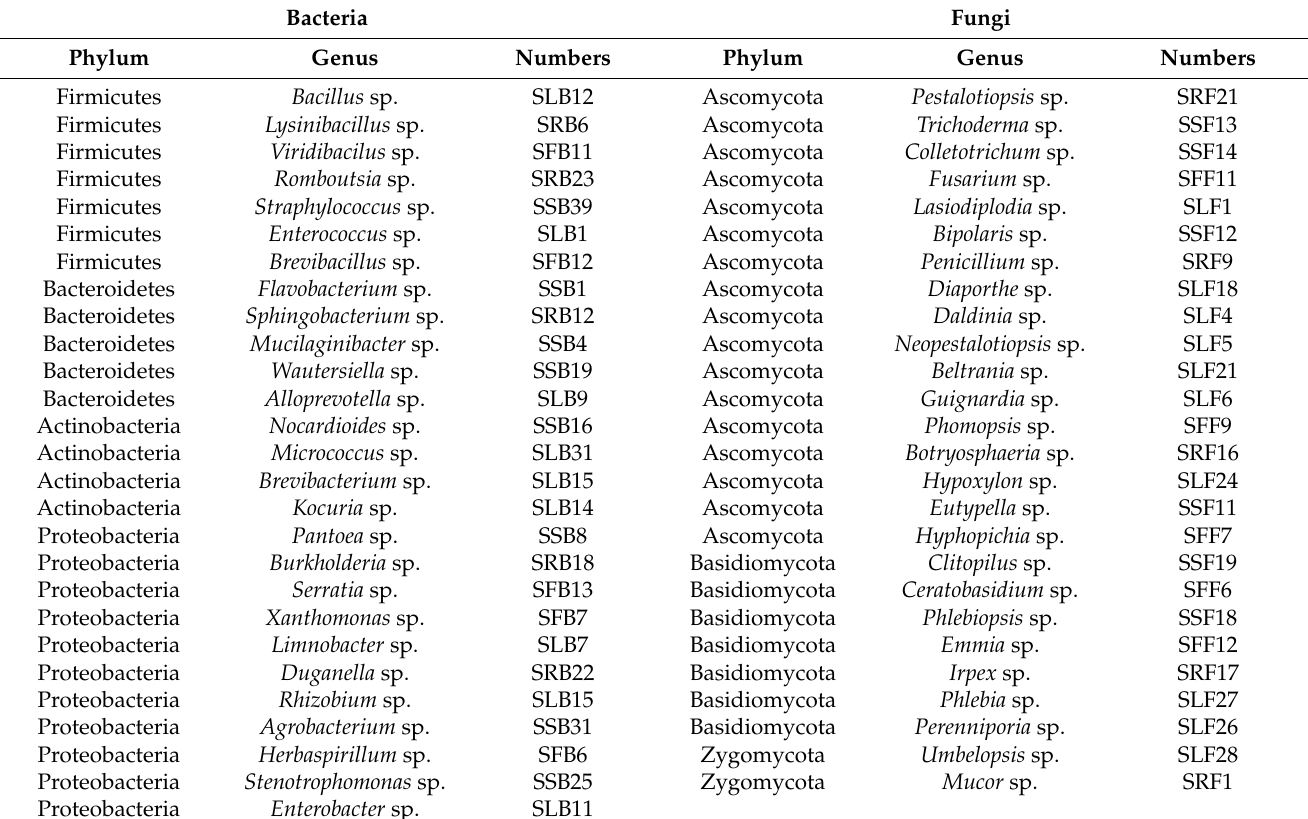
Table 1. Representative endophytic bacterial and fungal strains isolated from S. sphenanthera